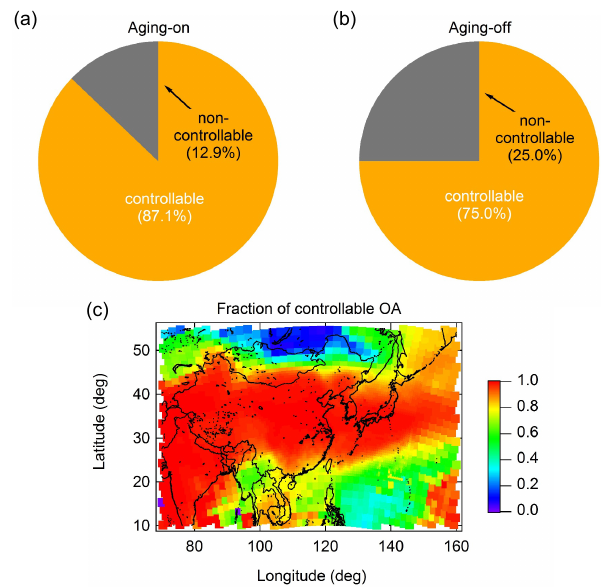
Figure 11. Period-averaged (24 March–26 April 2009) fraction of controllable and noncontrollable OA mass concentrations at an alti- tude of about 1km over the outer domain for simulations with (a) or without (b) aging. Period-averaged (24 March–26 April 2009) frac- tion of controllable OA at an altitude of about 1km over the outer domain for the simulation with aging (c)